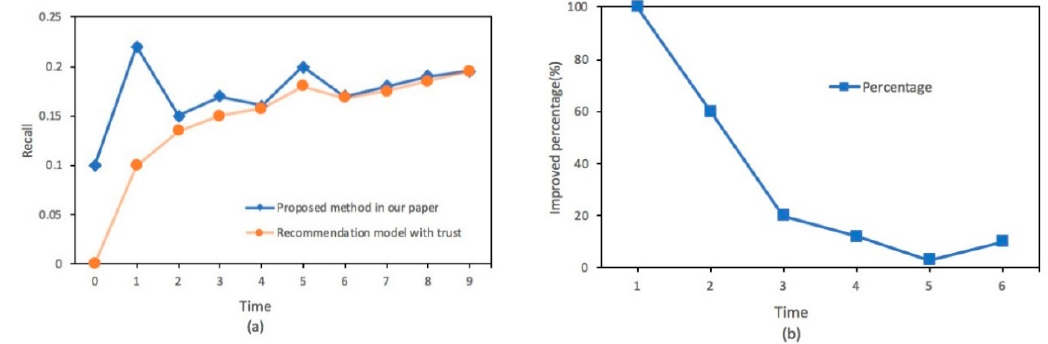
Figure 2. The result of the experiment. ( a ) The results of recall in a health and personal care shop; ( b ) the percentage of improvement of recall in the health and personal care shop.